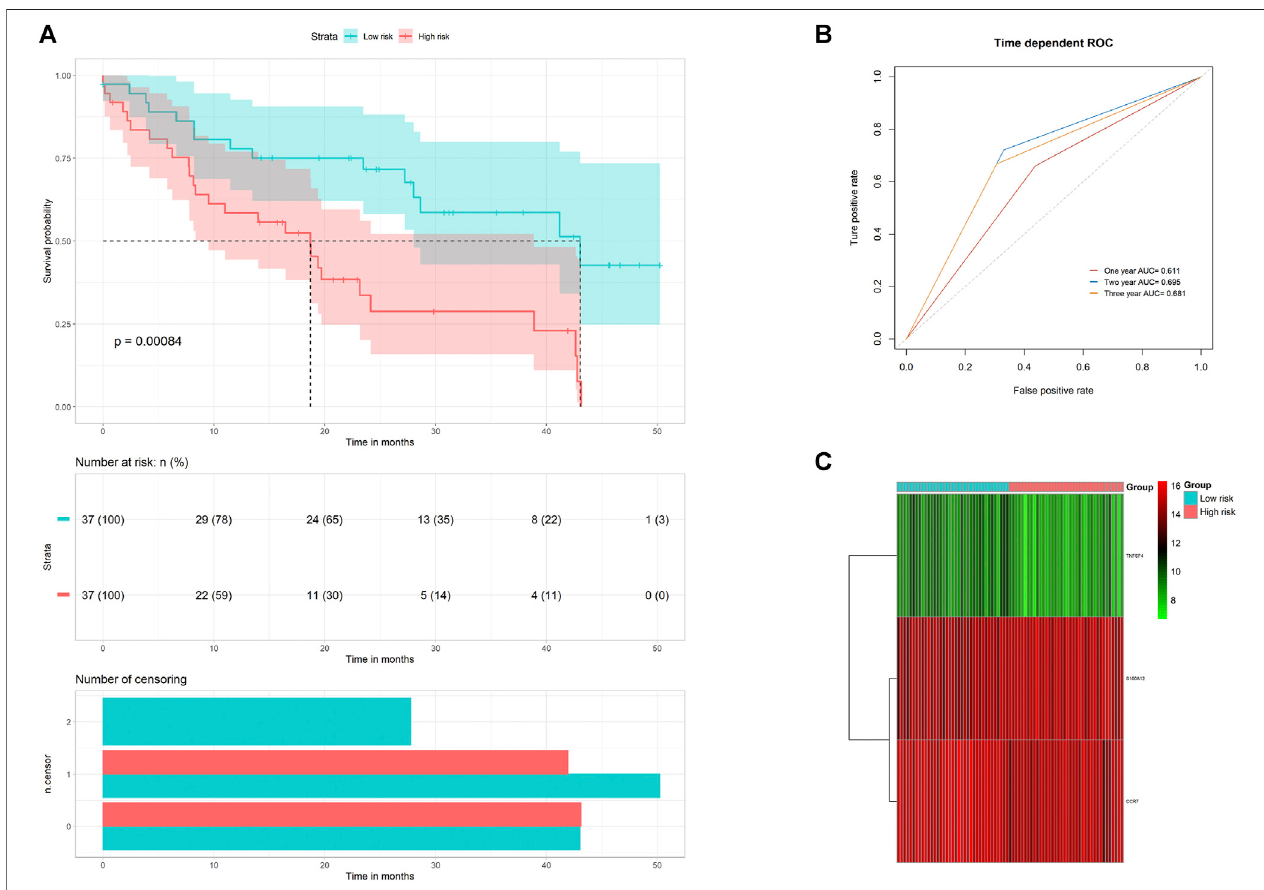
FIGURE3| Riskscoreanalysisofthethree-geneprognosticmodelintheGSE28042trainingcohort. (A) Survivalcurveforpatientswithlow-orhigh-riskscores. (B) ROC curves for forecasting overall survival. (C) Heat map for gene expressions.